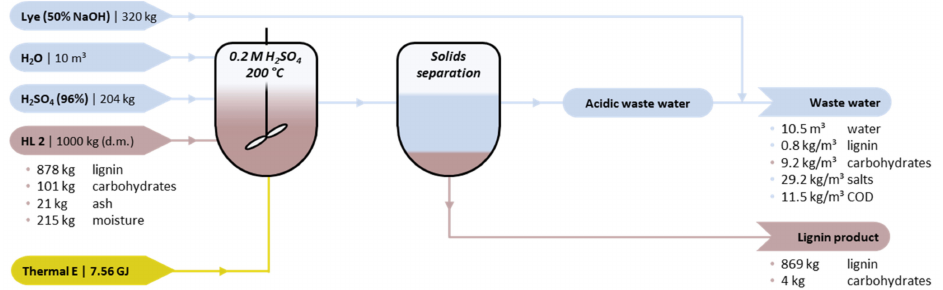
Figure 9. Simplified mass flow scheme for the acid hydrolysis of 1000 kg HL2. Washing steps are not included for simplicity. Process parameters: 0.2 M H 2 SO 4 , W lign = 0.1, and T = 200 ◦ C.